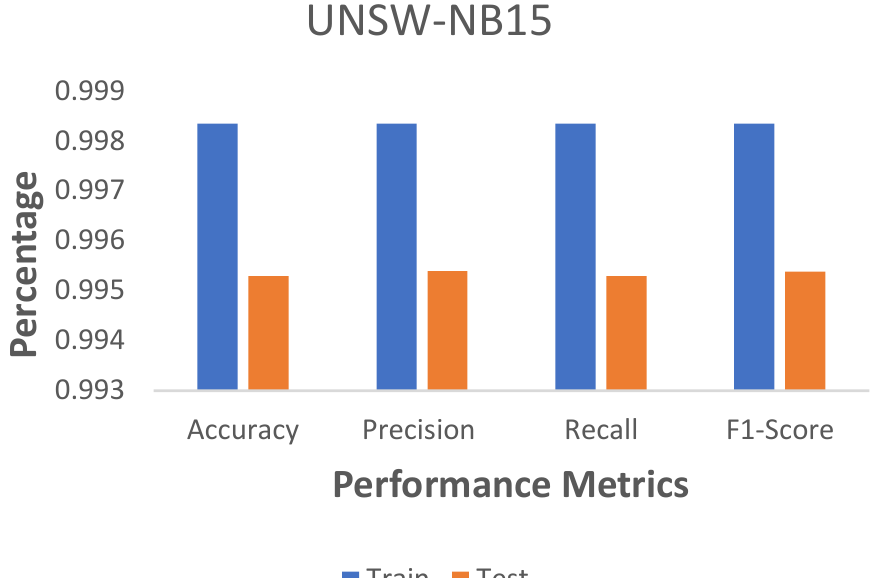
Figure 16. Performance Metrics on UNSW-NB15 Dataset.